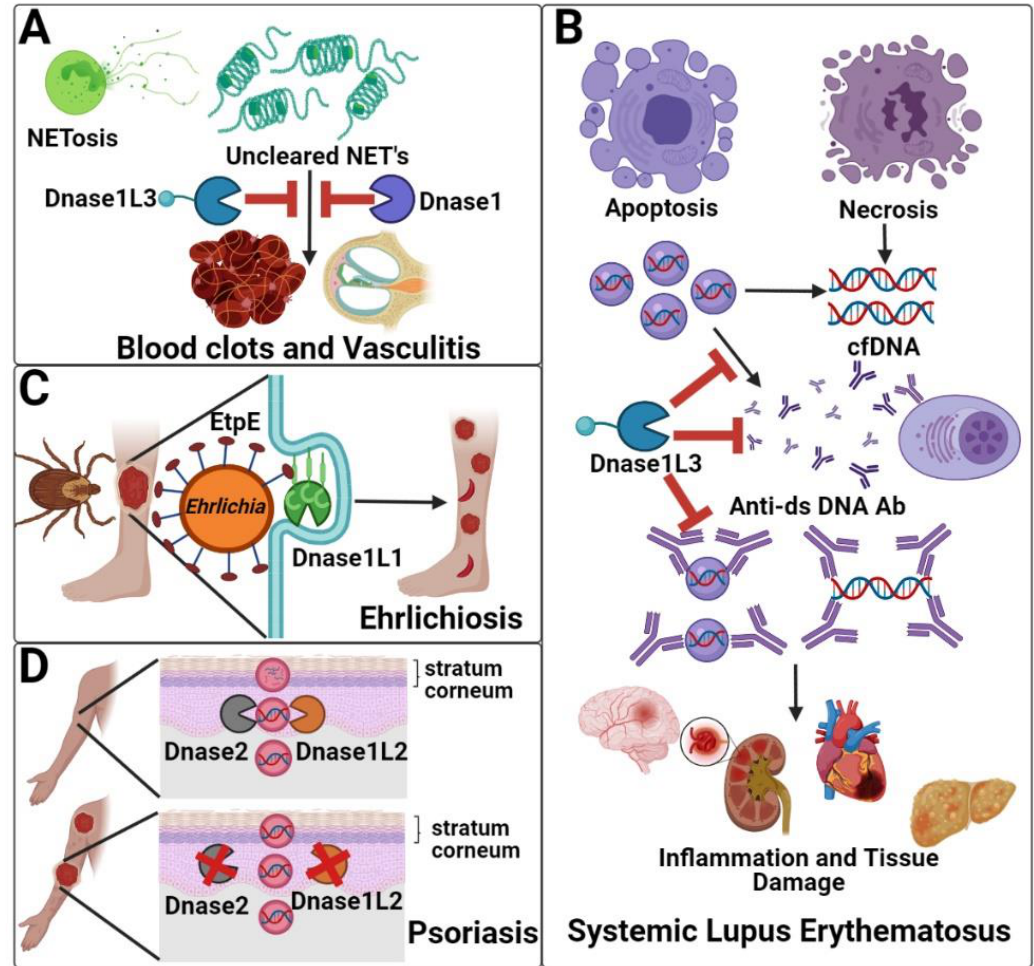
Figure 2. Dnase1 family members in disease. ( A ) NETosis releases chromatin into extracellular spaces. Dnase1 and Dnase1L3 absence may reduce NET clearance, which causes inflammation, resulting in blood clots and vasculitis. ( B ) Dnase1 and Dnase1L3 both process cfDNA. Dnase1L3 further digests DNA in microparticles, which prevents the anti-dsDNA autoantibody production and immune complex formation that leads to SLE. ( C ) After transmission by ticks, Ehrlichia spp. use EtpE to bind to the GPI anchor of Dnase1L1 for internalization and disease pathogenesis. ( D ) Dnase1L2 and Dnase2 deficiency is associated with psoriasis due to the failure to degrade the DNA within the nucleated cells in the stratum corneum during keratinocytes differentiation.